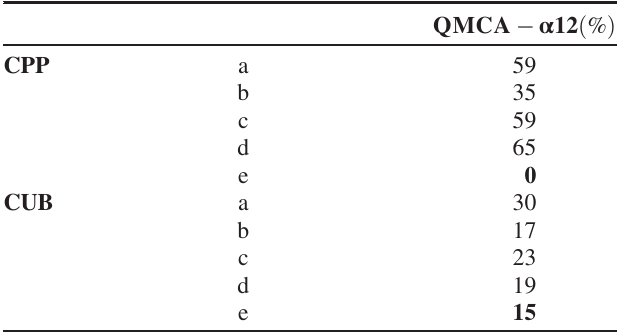
TABLE III. Percent of individual options students have selected on QMCA − α 12 . The total percent exceeds 100% because students were instructed to “ choose all that apply. ” The bold numbers represent the correct choices.